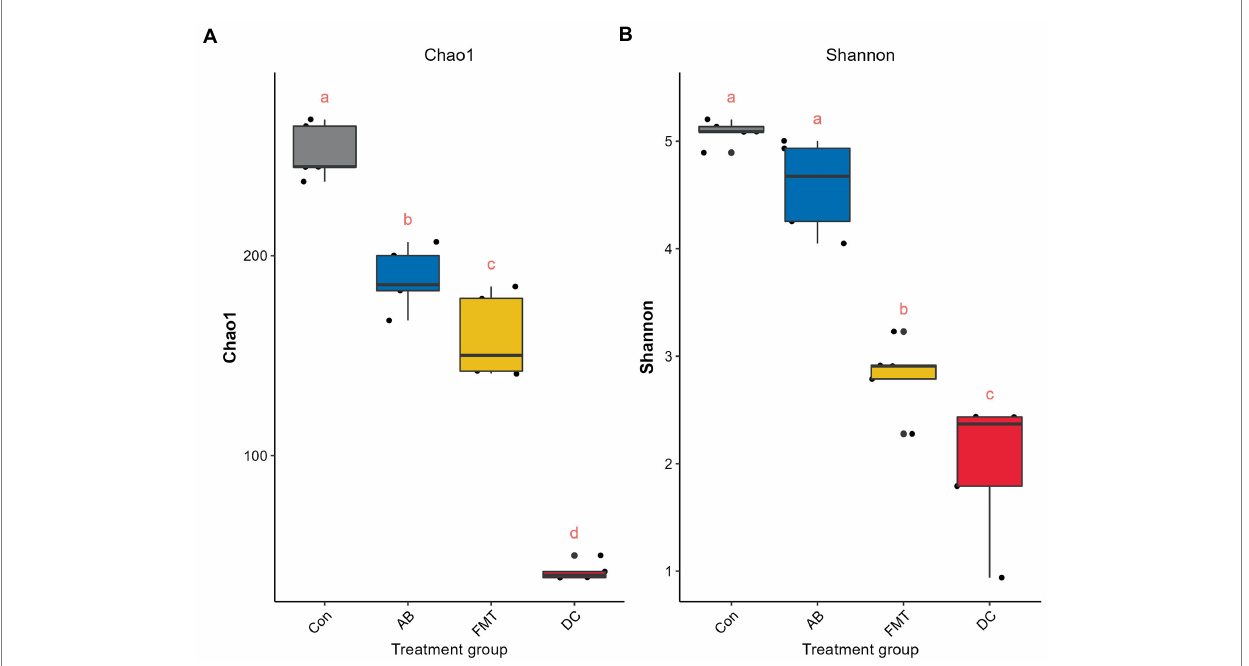
FIGURE 6 Comparisons of the alpha diversity, Chao 1 (A) and Shannon (B) index. The same letter indicates that there was no significant difference between the groups; a different letter indicates a statistically significant difference between the groups. Con, Control group; FMT, fecal microbiota transplantation group; AB, antibiotic group; DC, donor group.